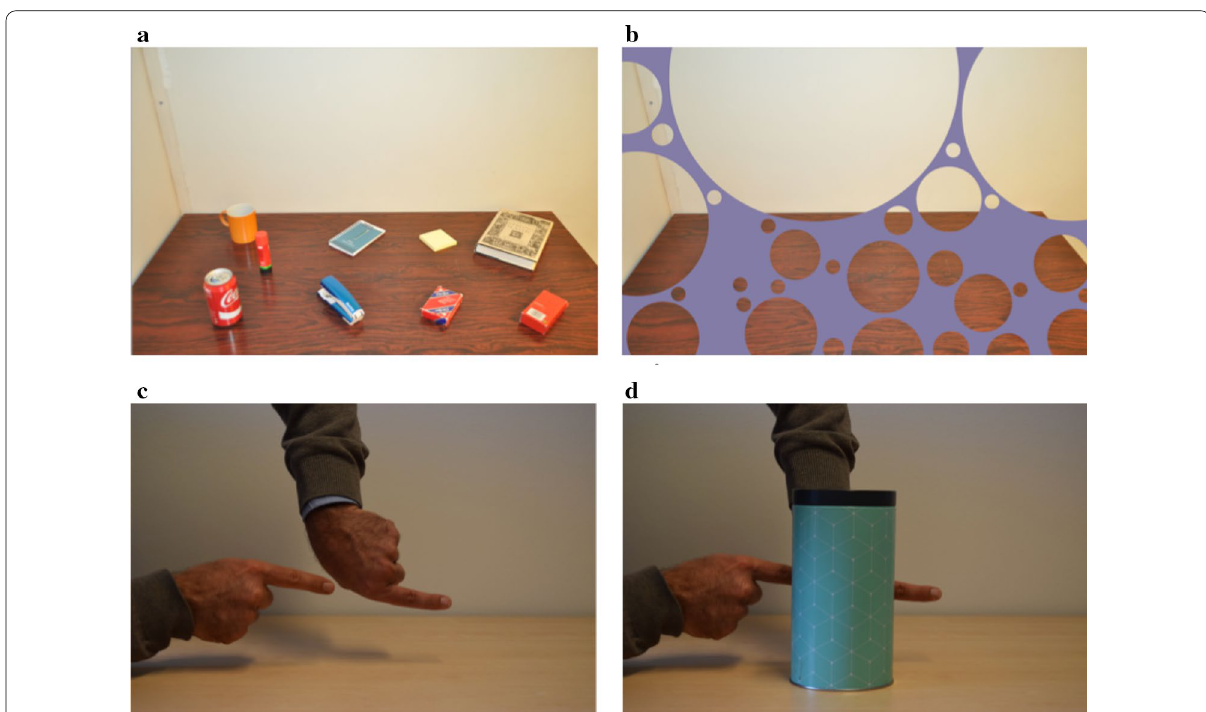
Fig. 1 Top panels: A demonstration of the illusion of absence. Although all the objects in panel ( a ) are hidden behind the violet ”bubbled” occluder in panel (b ), it is curiously difficult to imagine that they are really there. Bottom panels: A demonstration of amodal completion. The two fingers are experienced as a single long finger when they are partially occluded by the box (panel d ). Note that this illusory impression persists even though it is quite absurd and contradicts your conscious knowledge. Top row adapted from The Other Side of Magic: The Psychology of Perceiving Hidden Things by V. Ekroll, B. Sayim and J. Wagemans, 2017, Perspectives on Psychological Science, 12(1), p. 98. Copyright (2017) by SAGE Publications. Reprinted with permission. Bottom row adapted from “Never repeat the same trick twice—unless it is cognitively impenetrable” by V. Ekroll, E.